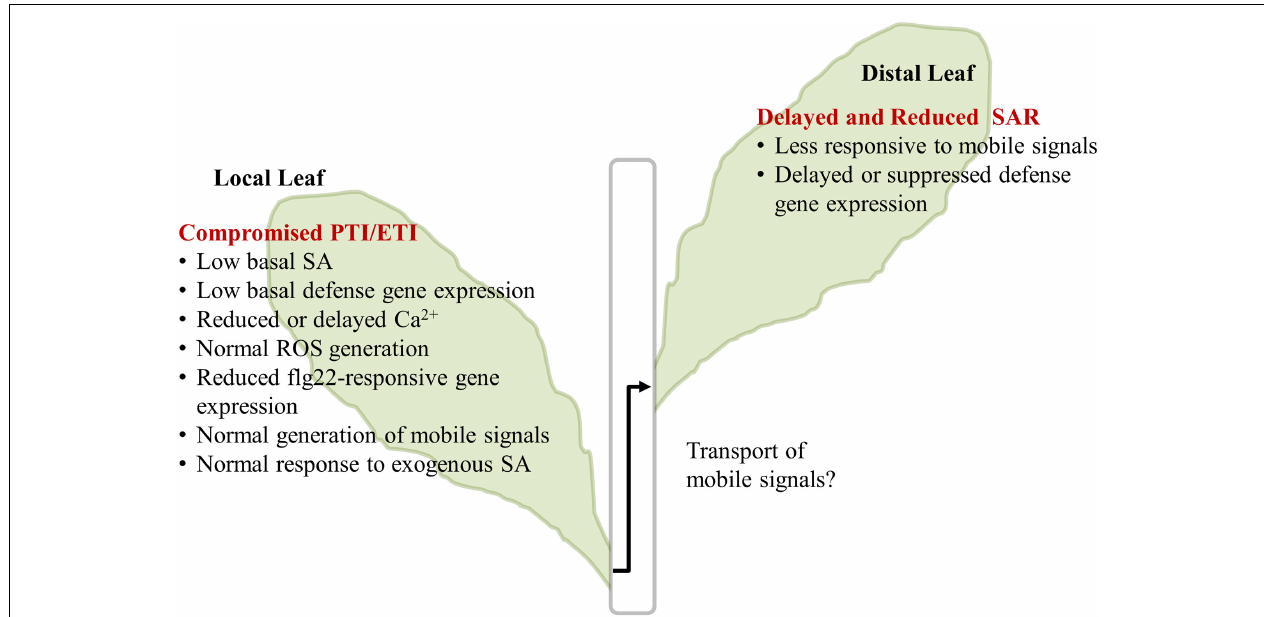
FIGURE 6 | Summary of InsP 5-ptase plants responses to flg22 and Pseudomonas syringae . The major results described in the paper are listed. The transport of mobile signals from local to distal leaves was not